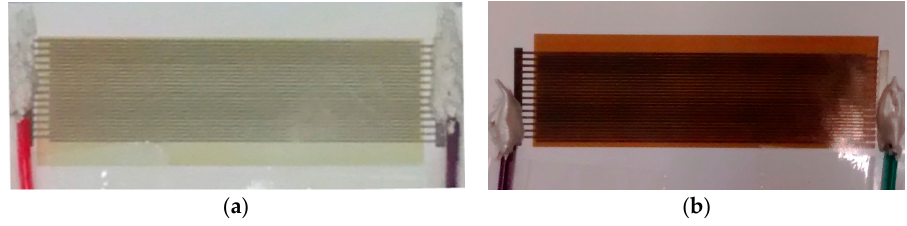
Figure 9. Inkjet-printed sensor module ( a ) before exposure; and ( b ) after exposure to H 2 S.